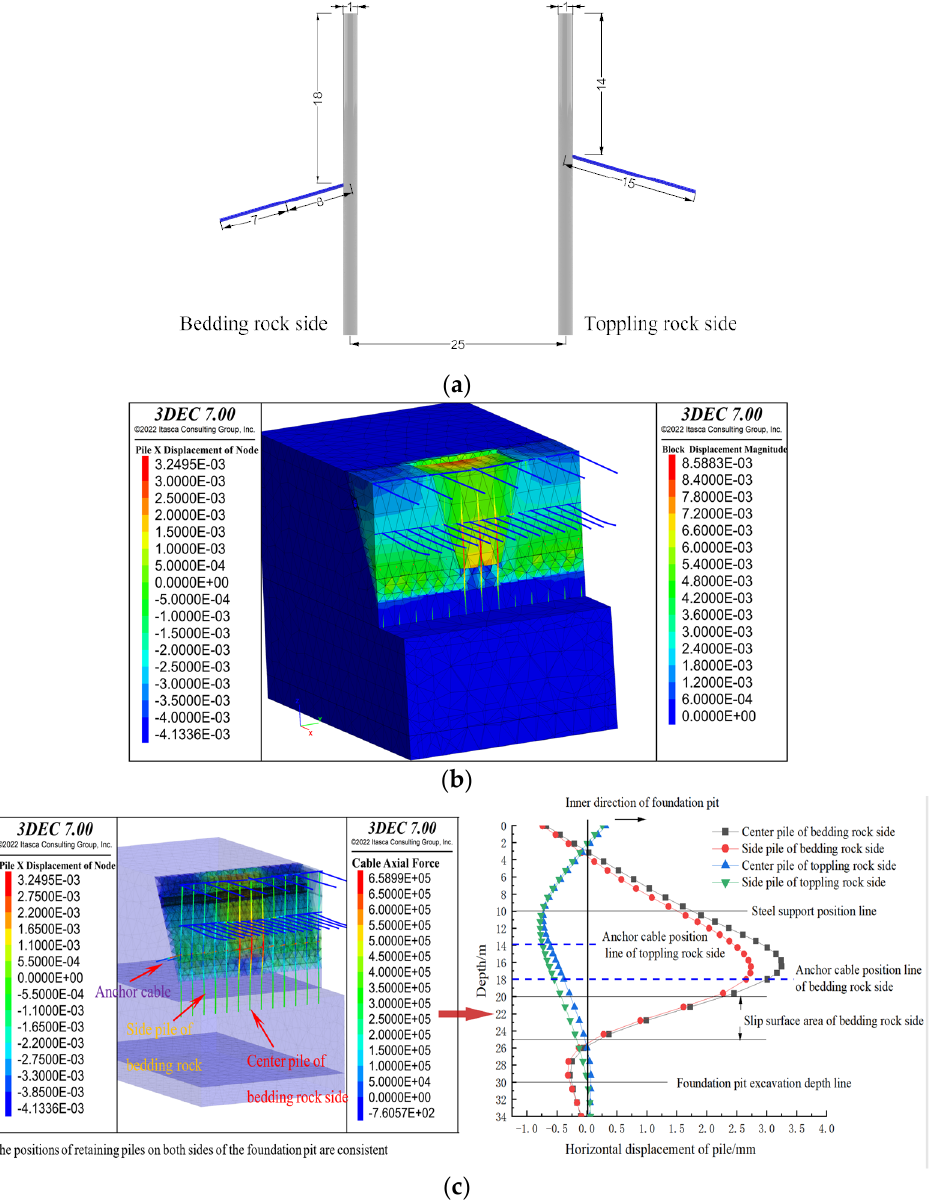
Figure 14. Analysis on the stress of combined support system of pile-bracing-anchor with 4.0 times pile spacing. ( a ) layout of anchor cables (unit: m); ( b ) displacement cloud on bedding rock side; ( c ) displacement of pile.